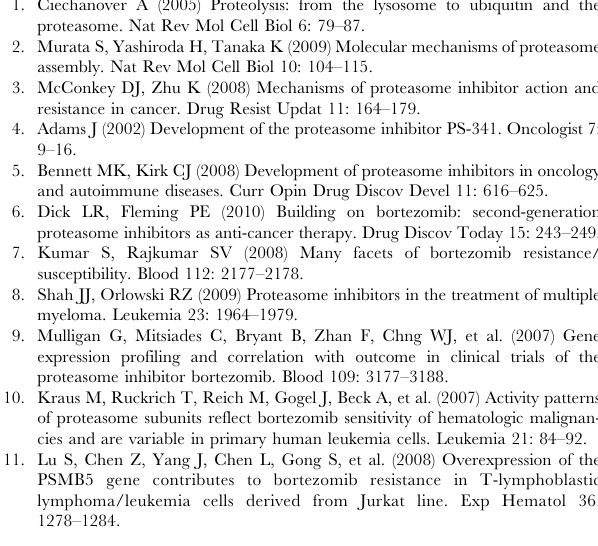
Figure S4 Characterization of LLL-boronate in BR100